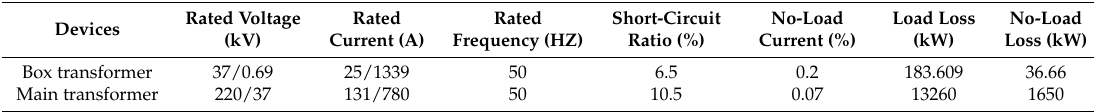
Table A2. Parameters of transformers in wind farm.